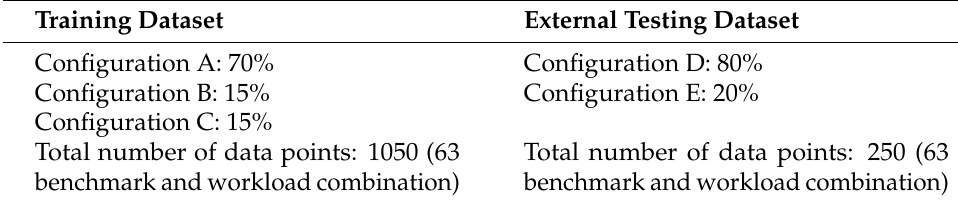
Table 3. Training and external dataset data point